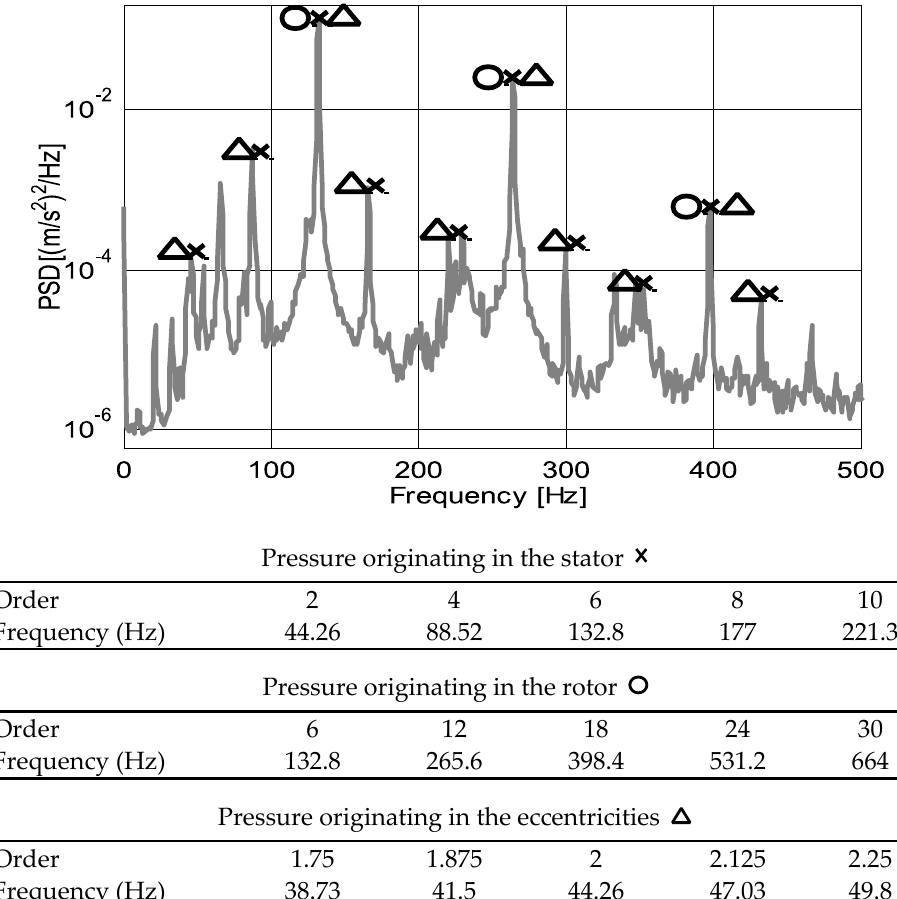
Figure 24. Rotors and stators of the prototype built for Qs36p15.